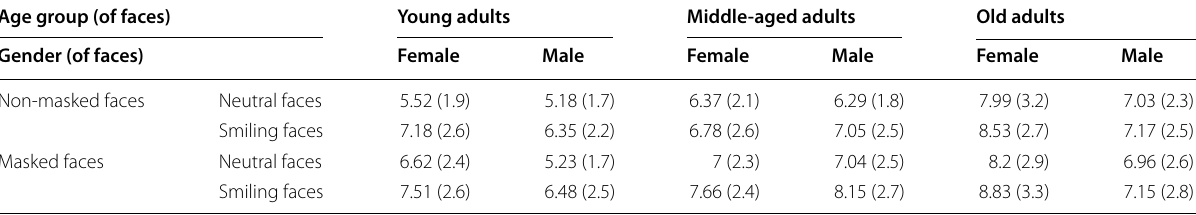
Note that larger numbers indicate lower accuracy